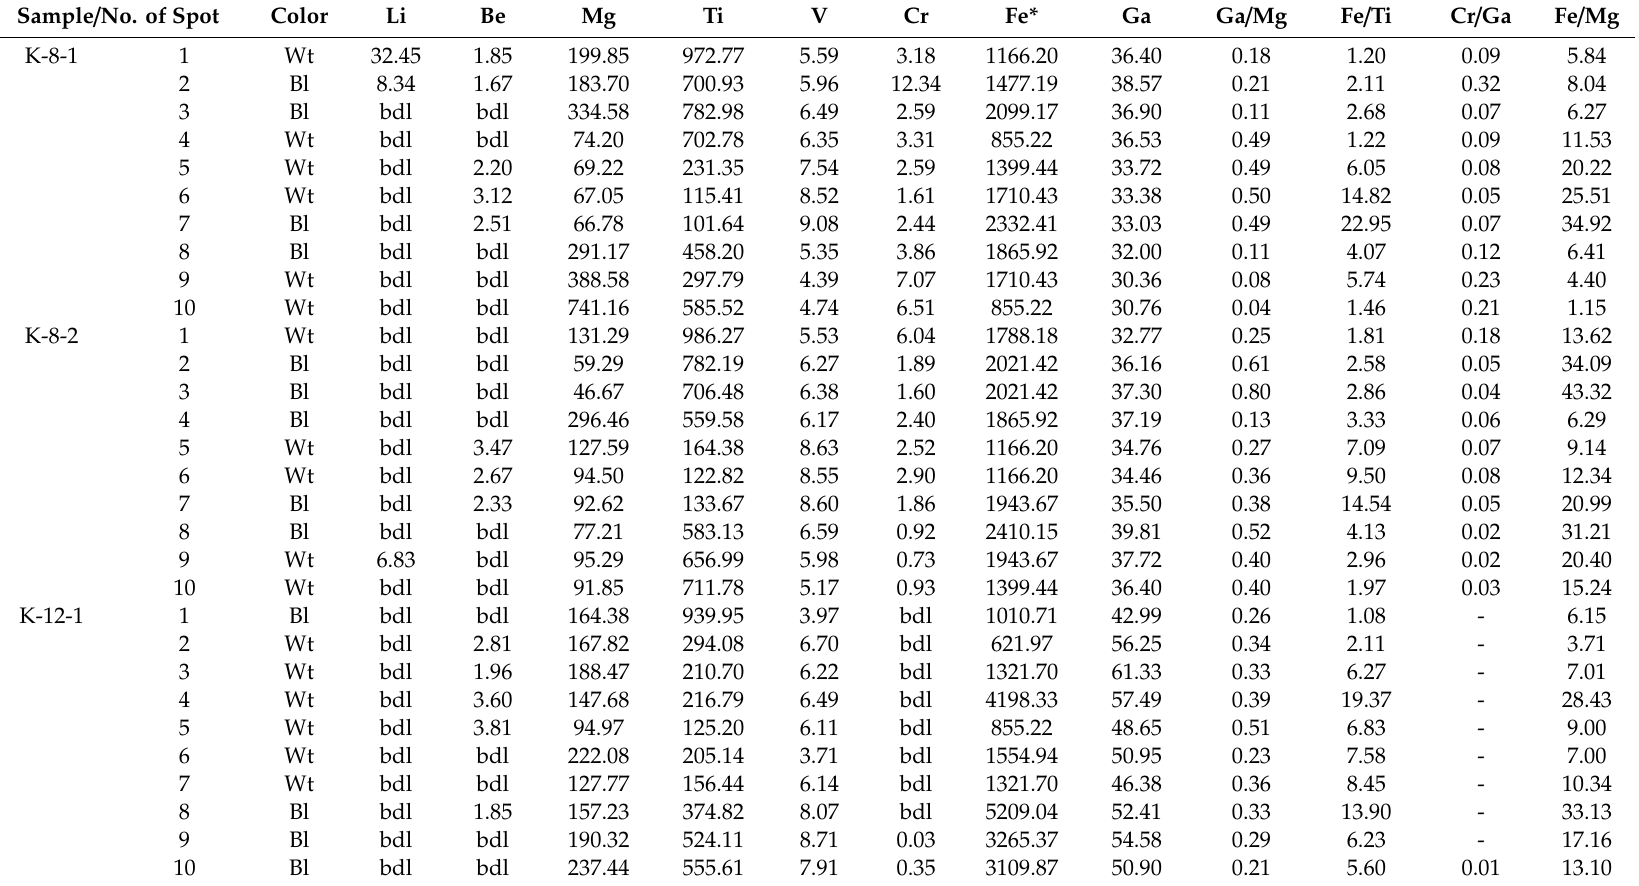
Table 1. Rim-to-rim LA-ICP-MS profiles of studied corundum-blue sapphire from anorthosites- kyshtymites (in µ g / g). Sample / No. of